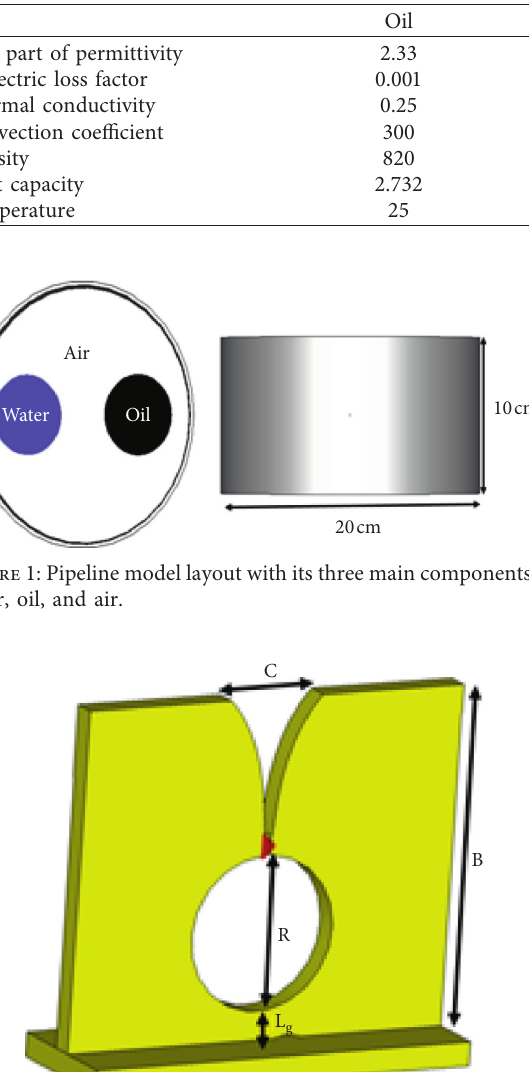
Figure 5. The single element parameters are reported in Table 3 for each configuration.